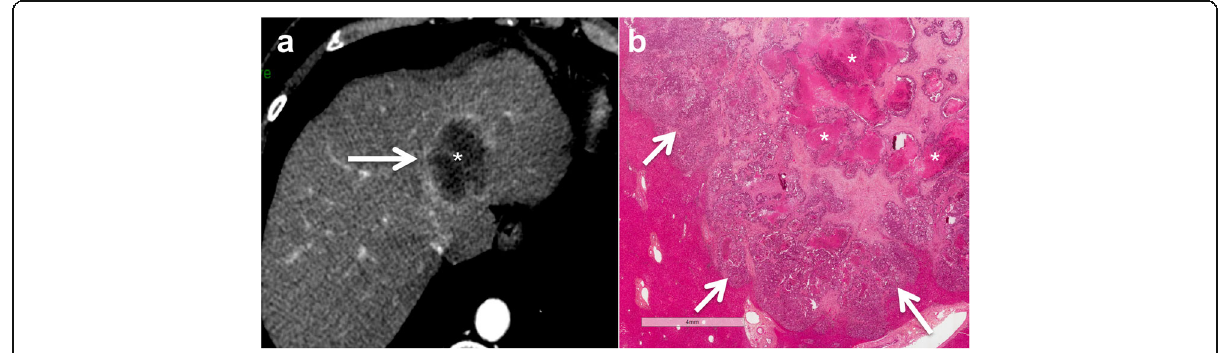
Fig. 3 Typical CT appearance of non-otherwise specific (NOS) adenocarcinoma liver metastasis in a 41-year-old female patient. Contrast enhanced CT image obtained during hepatic arterial phase ( a ) shows a 33 mm lesion in the left liver lobe with peripheral rim enhancement (arrow) and a hypoattenuating central area (star). Histological analysis ( b ) confirmed the presence of diffuse central acinar necrosis (stars) in the central part of the lesion. Note the proliferative peripheral tumor cells corresponding to the enhancing rim on CT image ( a , b